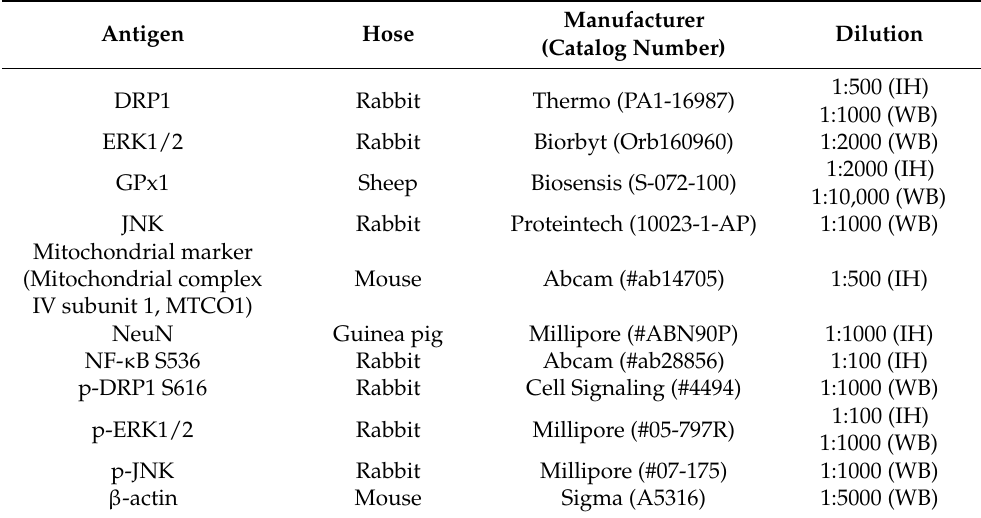
Table 1. Primary antibodies used in the present